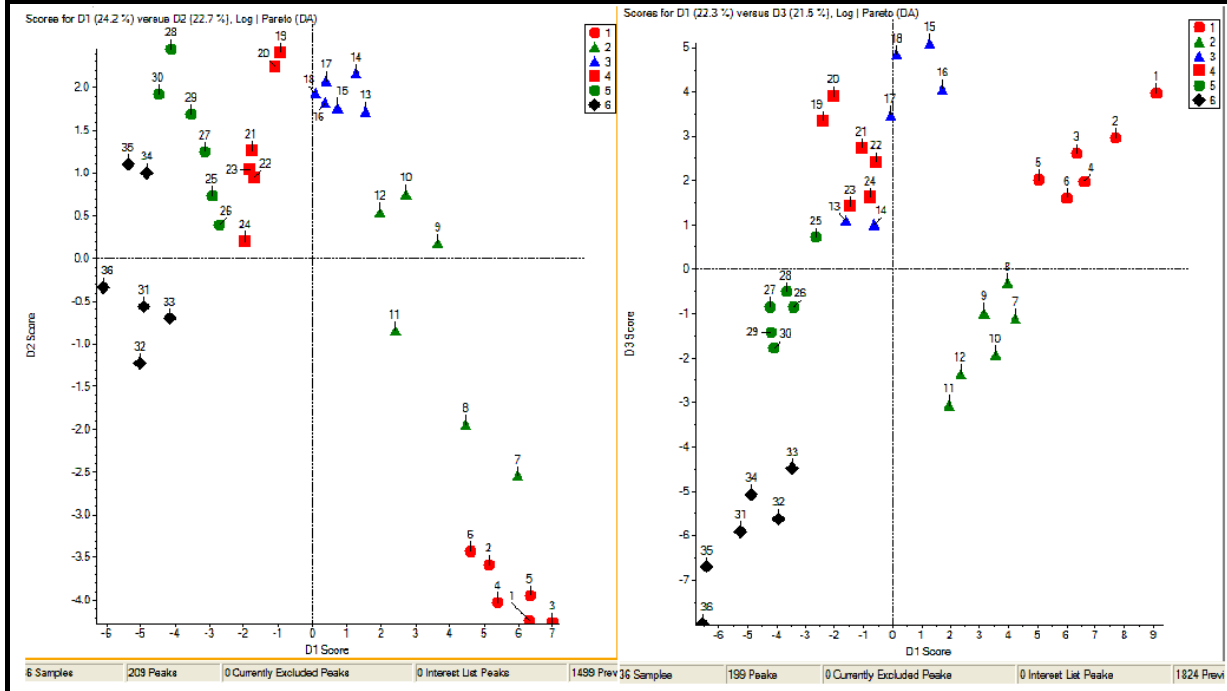
Figure 3b. PCA-DA score plots of the Pinus taeda L. RP (left panel) and HILIC (right panel) LC–ESI–MS (B) datasets generated with MarkerView 1.0. Groups are color-coded in accordance with embedded legend.